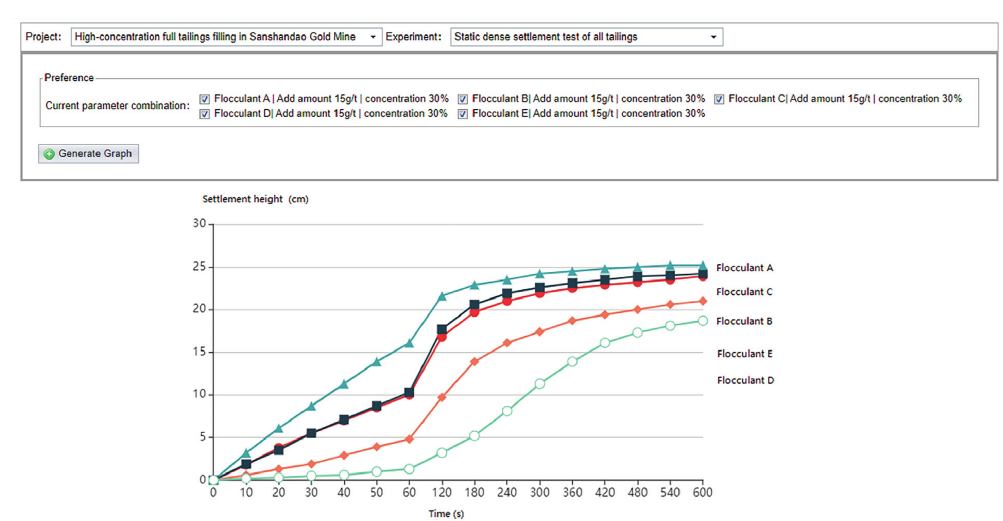
Figure 6: Analysis interface of backfill experiment data.